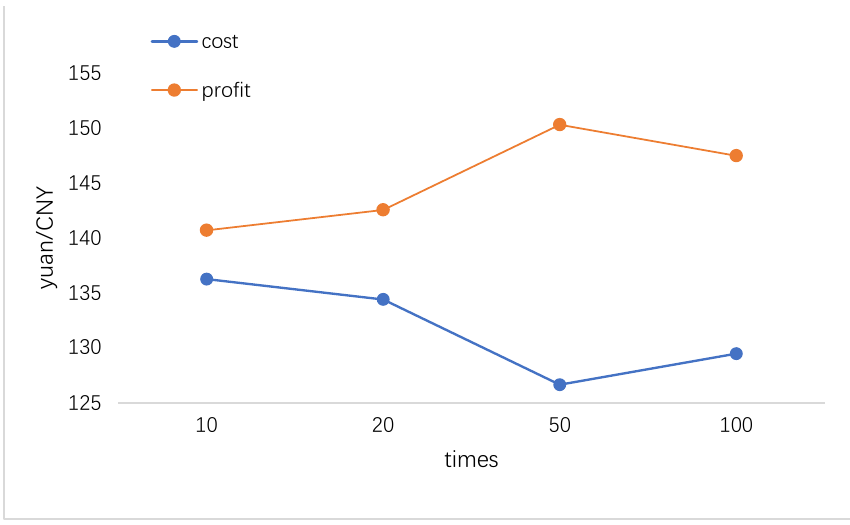
Figure 5. Costs and profits with Boltzmann cooling parameter value of 0.1.